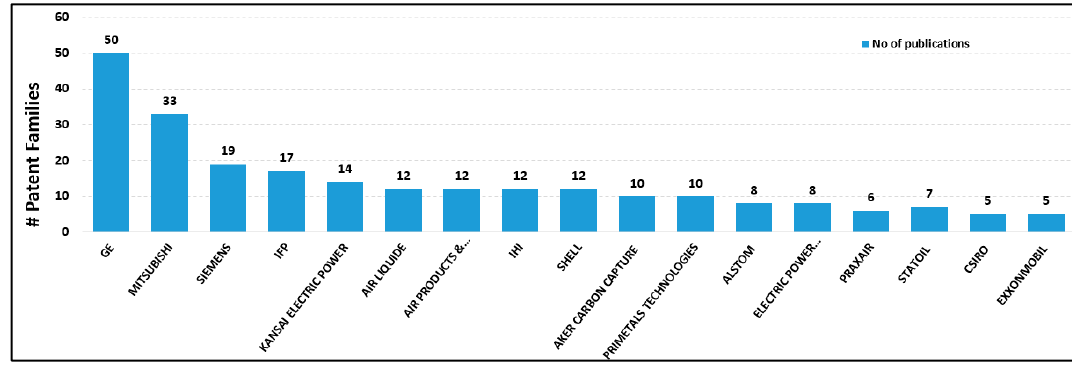
Figure 8. Top assignees (Industry).